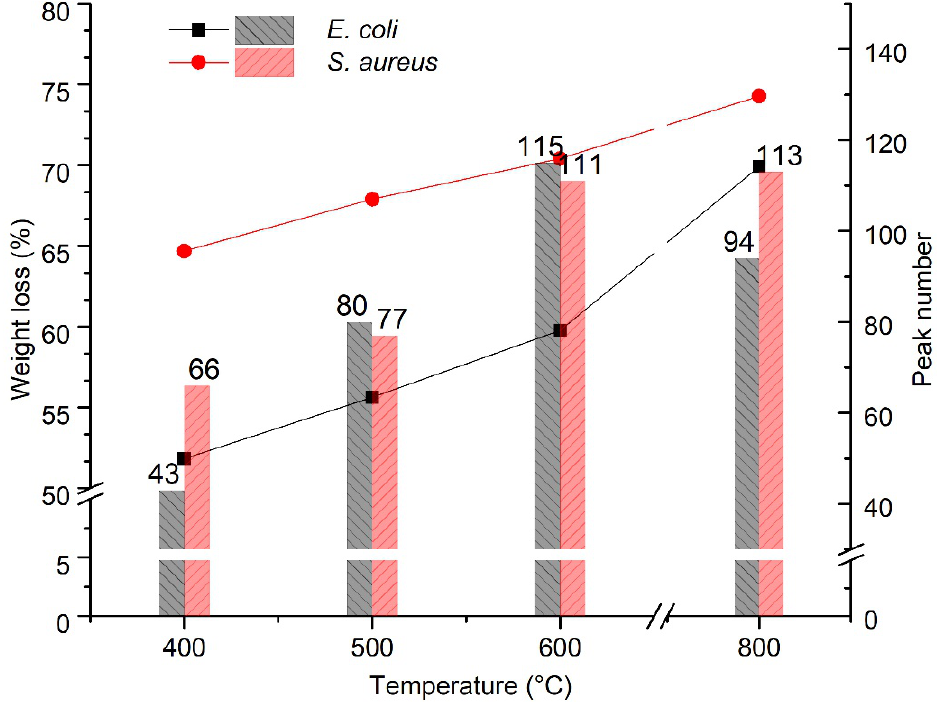
Figure 4. Weight loss and peak numbers of E. coli and S. aureus at different pyrolysis temperatures.